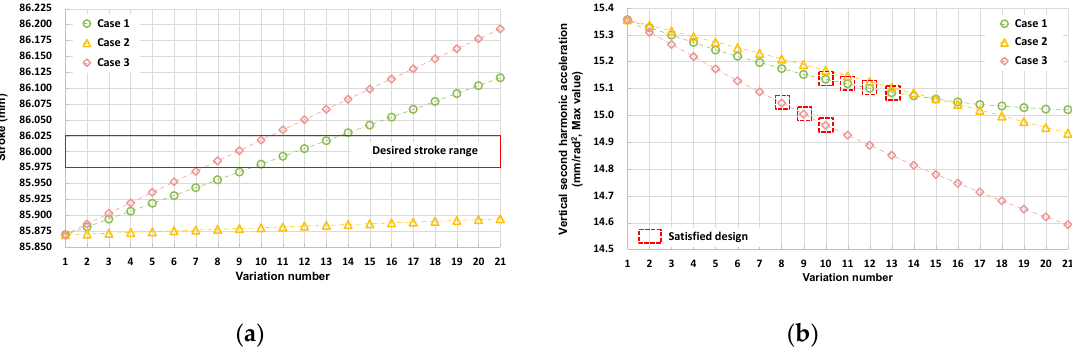
Figure 8. With the minimum length of r 4 and the maximum r 5 , influence on the maximum of vertical second harmonic acceleration sum of length change in: ( a ) r 1 and r 2 and ( b ) r 3 , r 6 , r 0 x , and r 0 y ; influence on the stroke of length change in: ( c ) r 1 and r 2 and ( d ) r 3 , r 6 , r 0 x , and r 0 y in the in-line four-cylinder engine.